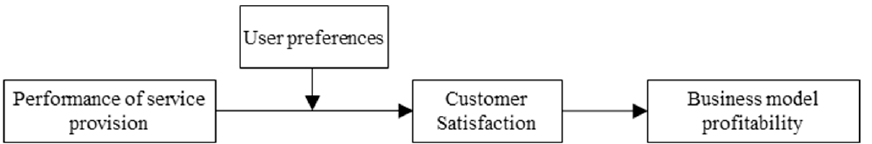
Figure 5. Presumed relationship between the performance of service provision and business model profitability (own figure).